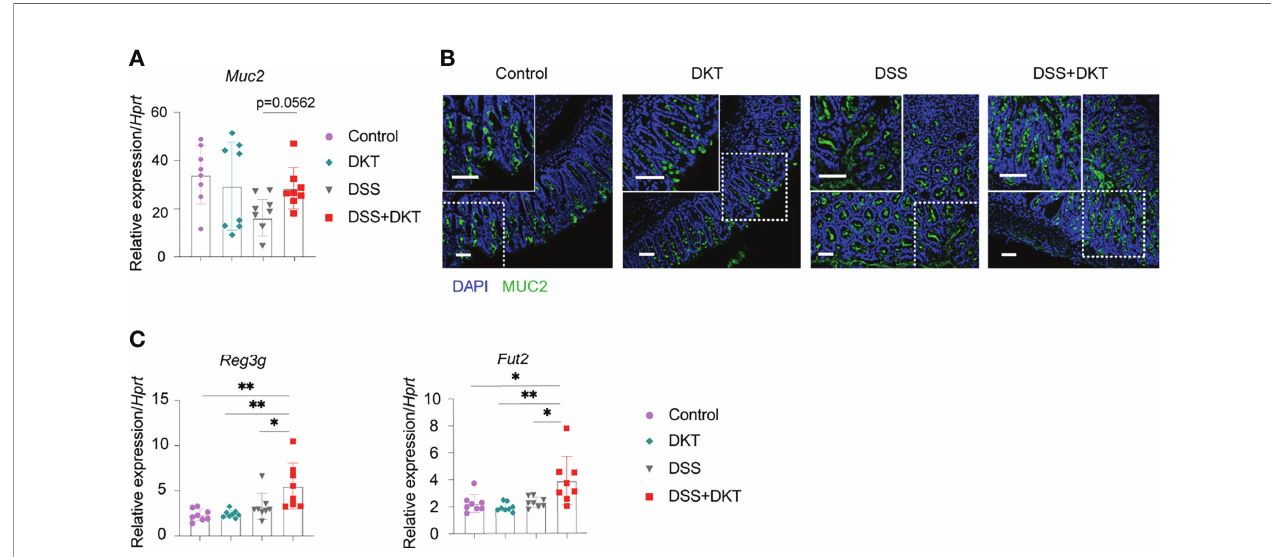
FIGURE 3 | DKT protects the integrity of colonic epithelium by upregulating Muc2 , the antimicrobial peptide gene Reg3 and the fucosyltransferase gene Fut2 . (A) Muc2 mRNA expression in the colonic enterocytes after colitis induction (N=8 per group). (B) Immuno fl uorescence images of MUC2 expression (green) and DAPI (blue) staining in the rectal colonic tissue (Control N=3, DKT N=3, DSS N=4, DSS+DKT N=4). Scale bars represent 50 m m, inset scale bars represent 50 m m. (C) Reg3g and Fut2 mRNA expression in the colonic enterocytes after colitis induction (N=8 per group). Each symbol (A, C) represents data from an individual mouse. (A, C) , results are pooled from two independent experiments with four mice in each experimental group and show means ± SEM; *p<0.05, **p<0.01. Statistical analysis was performed using One-way ANOVA with Tukey ’ s multiple comparisons